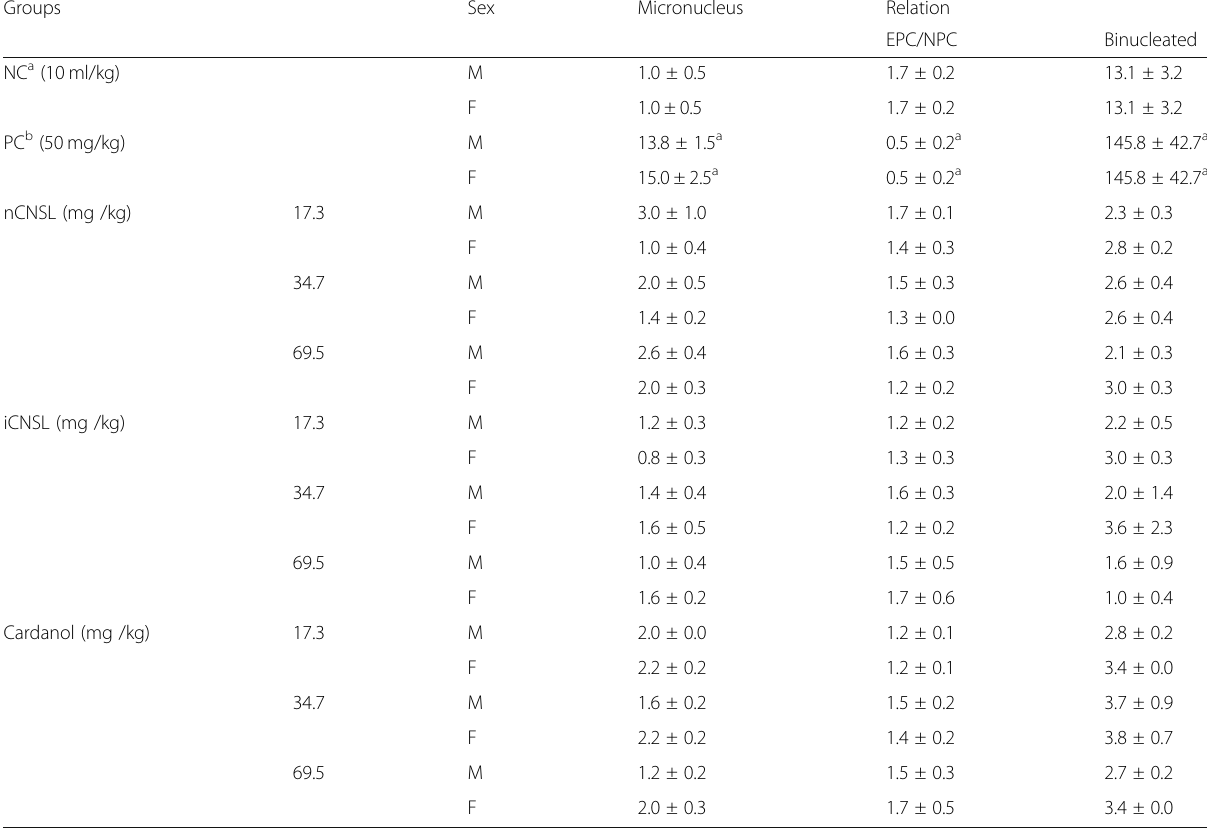
Table 2 Determination of binucleated cells with micronuclei (mean ± SD) in bone marrow cells of mice after 24 h of oral administration of nCNSL, iCNSL and Cardanol